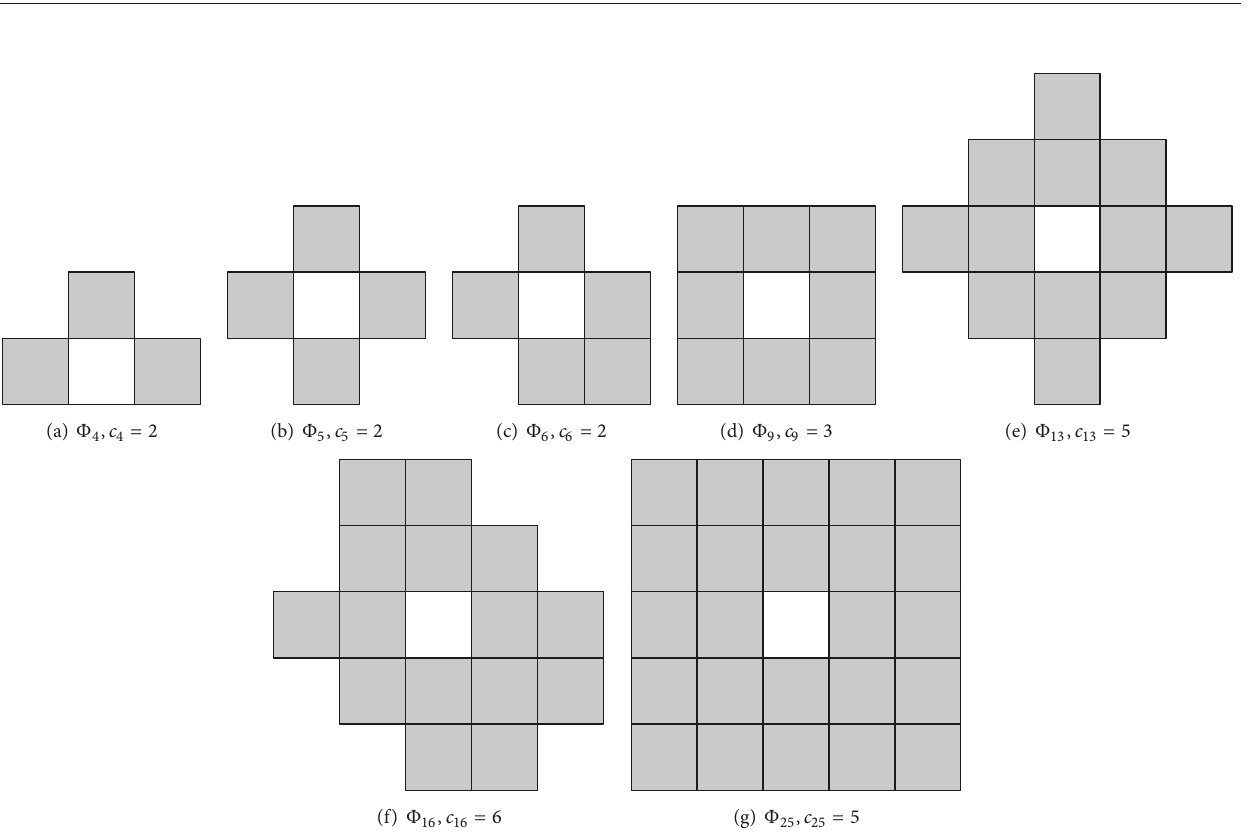
Figure 1: Neighborhood set (shaded region) for